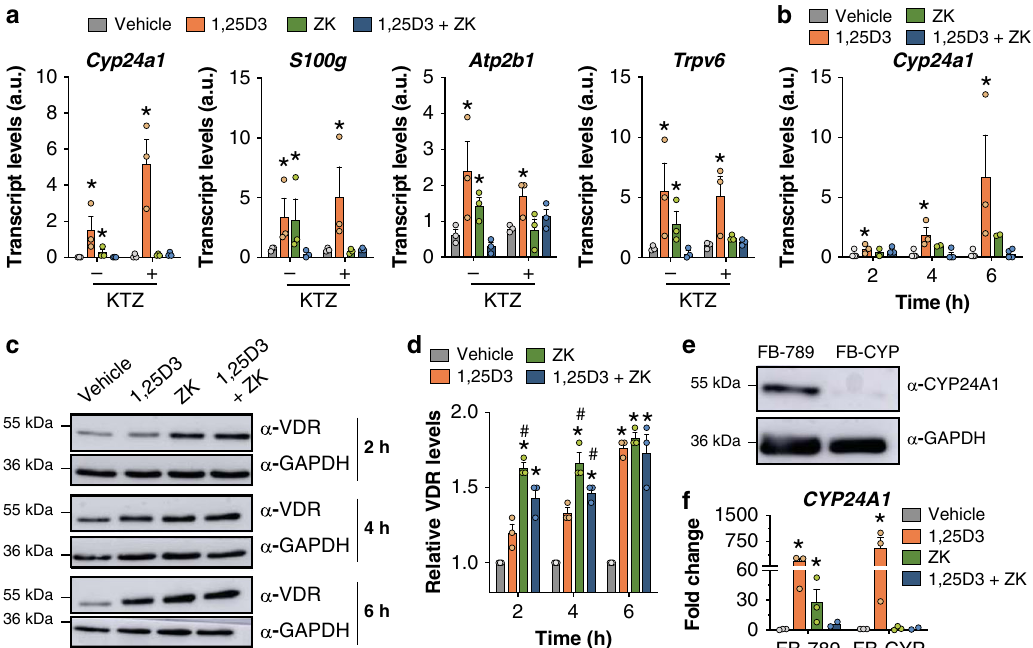
Fig. 1 ZK activities in rat intestinal epithelial cells and in human fi broblasts. a Relative transcript levels of Cyp24a1 , S100g, Atp2b1 , and Trpv6 after a 4 h treatment with vehicle, 100 nM 1,25D3, 1 µ M ZK, or 100 nM 1,25D3 and 1 µ M ZK in IEC-18 cells, pre-treated ( + ) or not ( − ) with 5 µ M ketoconazole (KTZ) for 2 h. n = 3 independent biological replicates/condition. b Relative Cyp24a1 transcript levels in IEC-18 cells treated with vehicle, 100 nM 1,25D3, 1 µ M ZK, or 100 nM 1,25D3 and 1 µ M ZK for 2, 4, and 6 h. n = 3 independent biological replicates for vehicle, 1,25D3, and 1,25D3 and ZK. n = 2 independent biological replicates for ZK. Representative VDR immunoblot ( c ) and average fold-change ( d ) of total extracts of IEC-18 cells treated for 2, 4, and 6 h with vehicle, 100 nM 1,25D3, 1 µ M ZK, or 100 nM 1,25D3 and 1 µ M ZK. n = 3 independent biological replicates/condition. Unprocessed blots in Source Data. e Immunoblot of CYP24A1 protein in human FB-789 and FB-CYP fi broblasts. GAPDH was used as loading control. Unprocessed blots in Source Data. f Fold change of CYP24A1 transcript levels in FB-789 and in FB-CYP fi broblasts treated for 6 h with vehicle, 100 nM 1,25D3, 1 µ M ZK, or 100 nM 1,25D3 and 1 µ M ZK. The levels of vehicle-treated cells were set as reference. n = 3 independent biological replicates/condition. Data in ( a ), ( b ), ( d ), and ( f ) are represented as mean + s.e.m. (standard error of mean). * p < 0.05 vs. vehicle, # p < 0.05 vs. 1,25D3; one-way ANOVA with Tukey post-hoc test. The exact signi fi cant p -values are provided in Supplementary Table